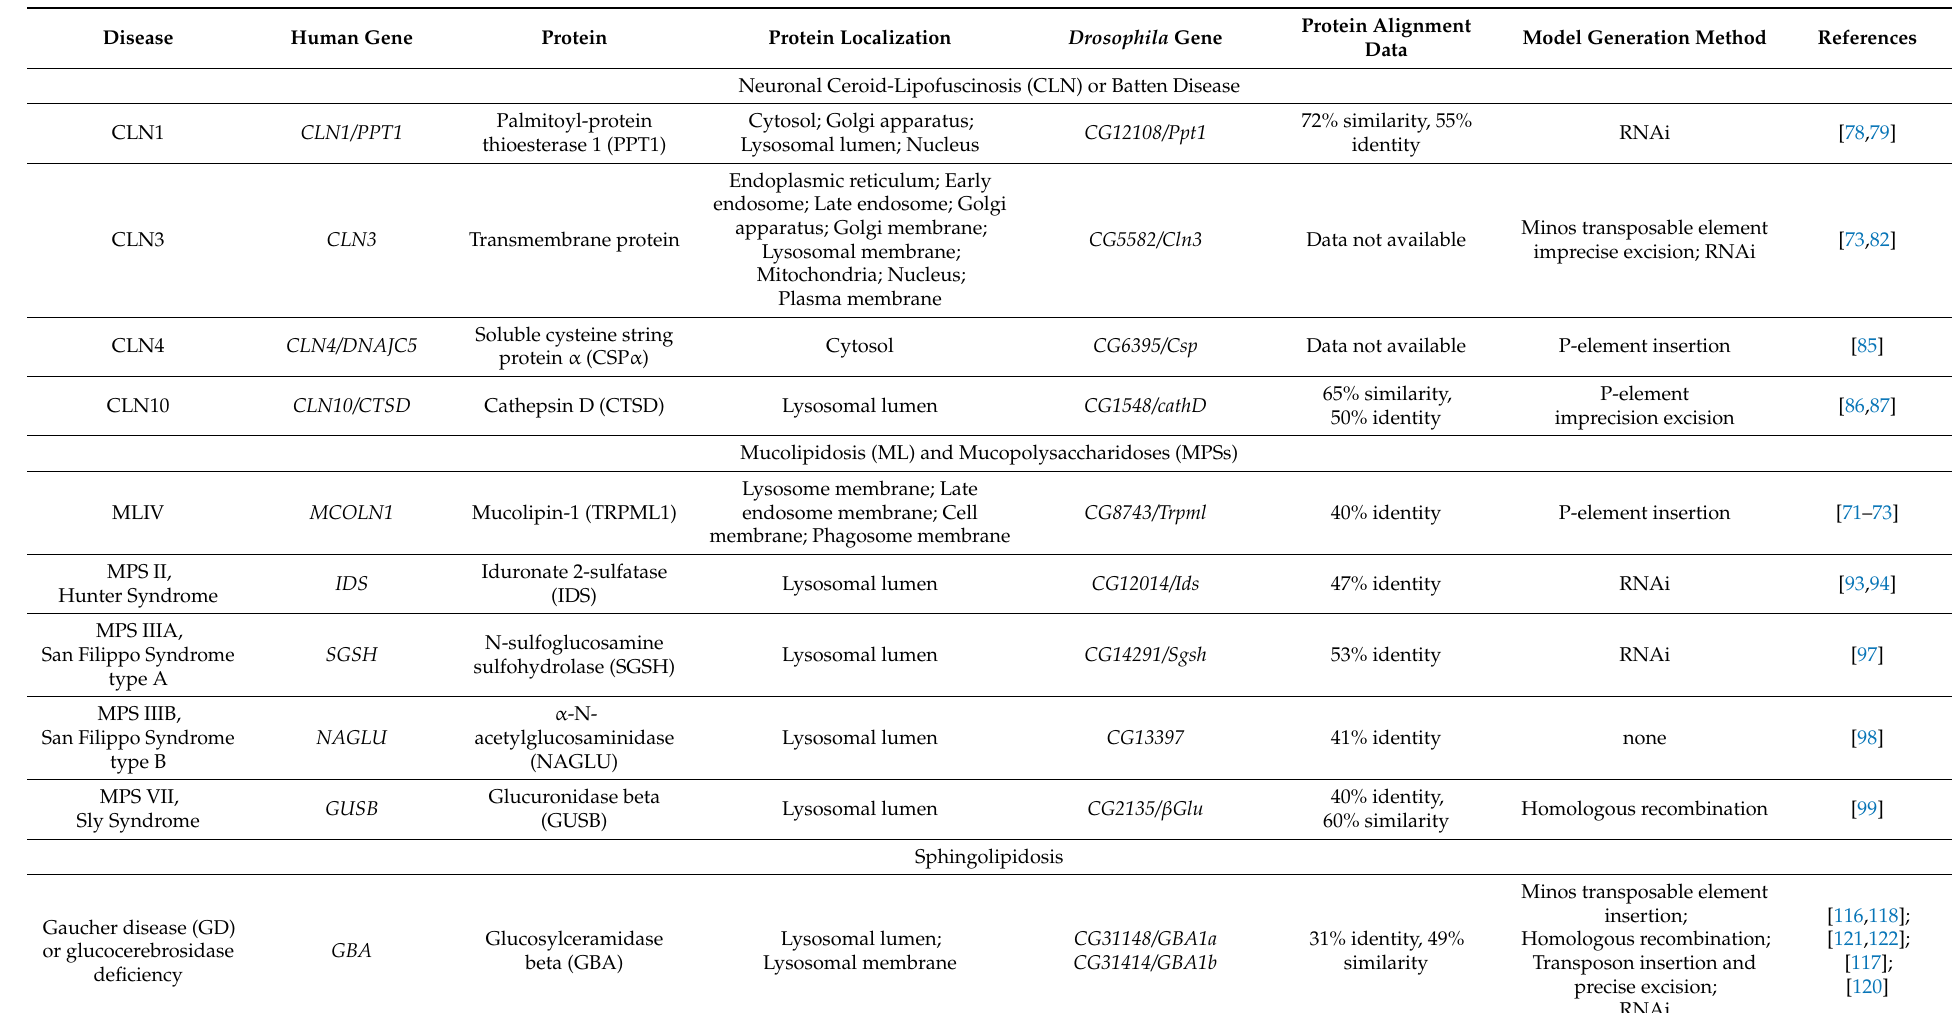
Table 1. Lysosomal storage disorder Drosophila